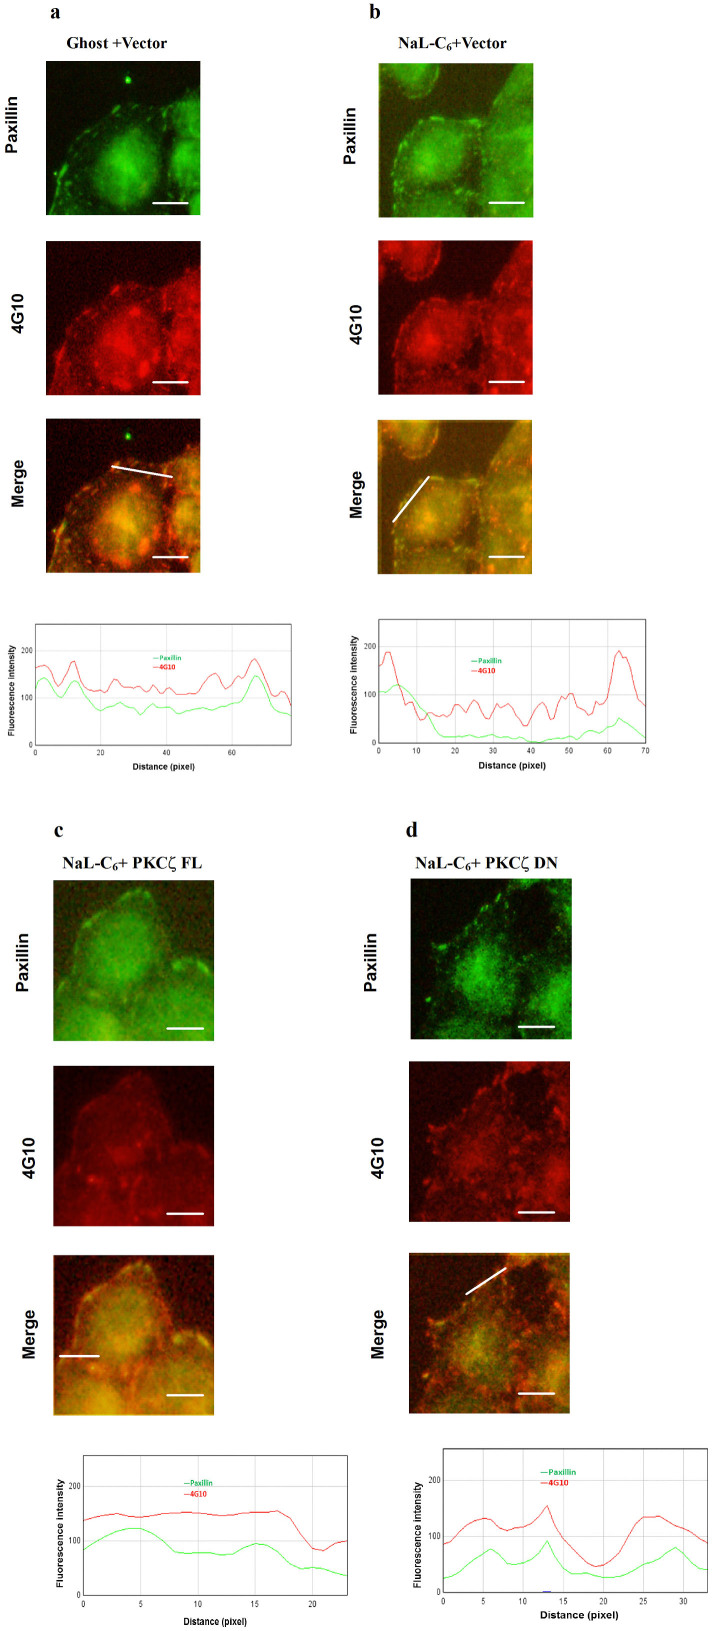
C6-ceramide nanoliposome-induced focal adhesion disassembly was regulated by dephosphorylation of paxillin through PKCζ activation.(a–d) MDA-MB-231 cells were transfected with vector(a–b), PKCζ FL(c), or PKCζ DN(d). Then, they were treated with ghost (a) or 20 μM ceramide nanoliposomes (b–d) before being co-stained with anti-paxillin antibody (green) and 4G10 (phospho-tyrosine specific antibody) (red).The profiles in the panel below show the fluorescence intensity patterns of focal adhesions from line scans in the merged images, which were analyzed by Image J. Bar = 5 μm.12 cells were analyzed per condition in each experiment.